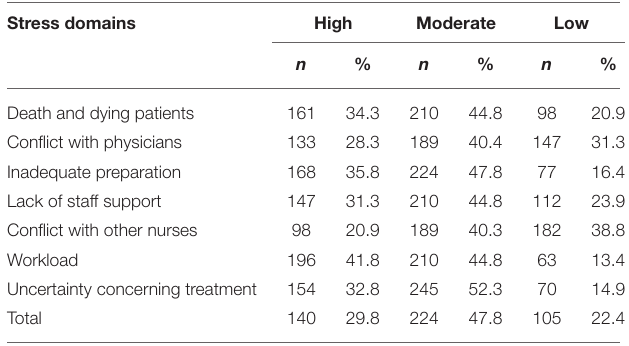
TABLE 6 | Distribution of the studied critical care nurses according to their stress level ( n = 469). Stress domains